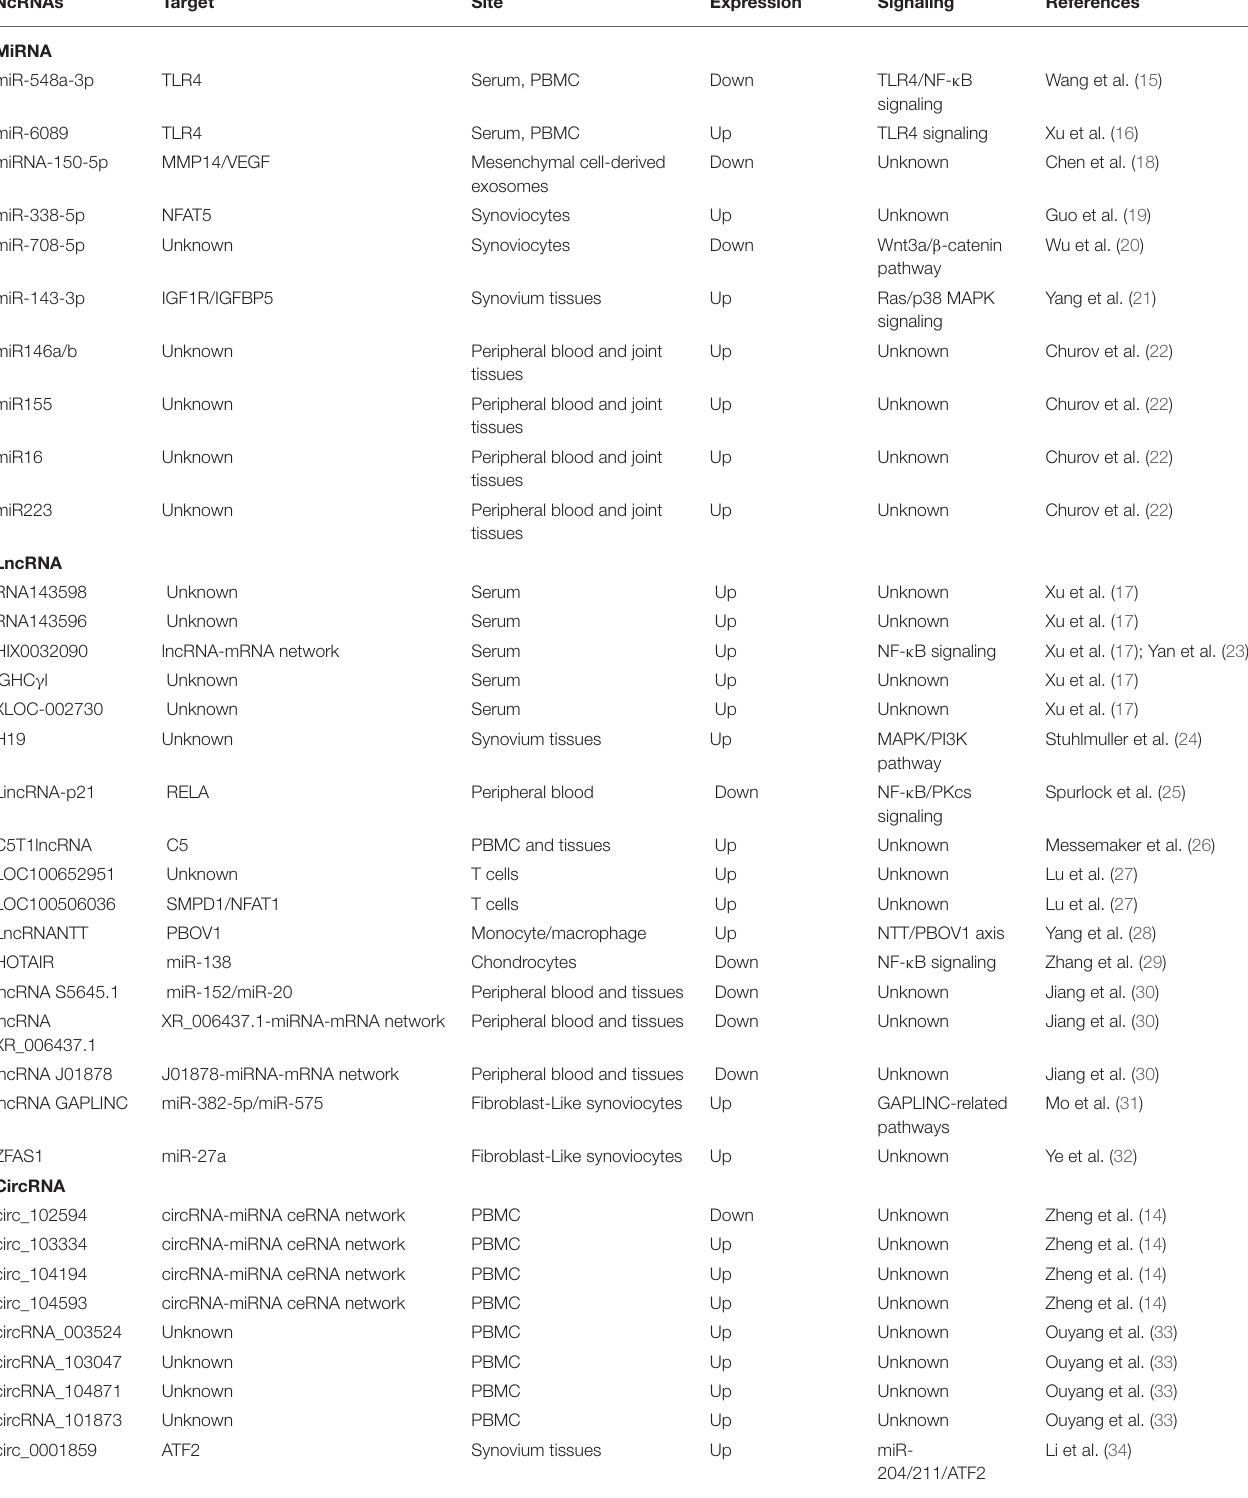
TABLE 1 | Aberrant expressed ncRNAs in